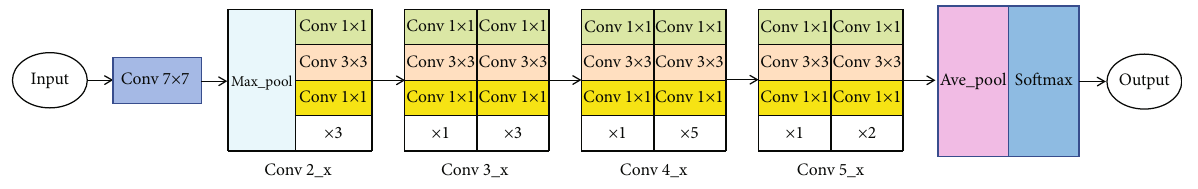
Figure 5: ResNet-50 network